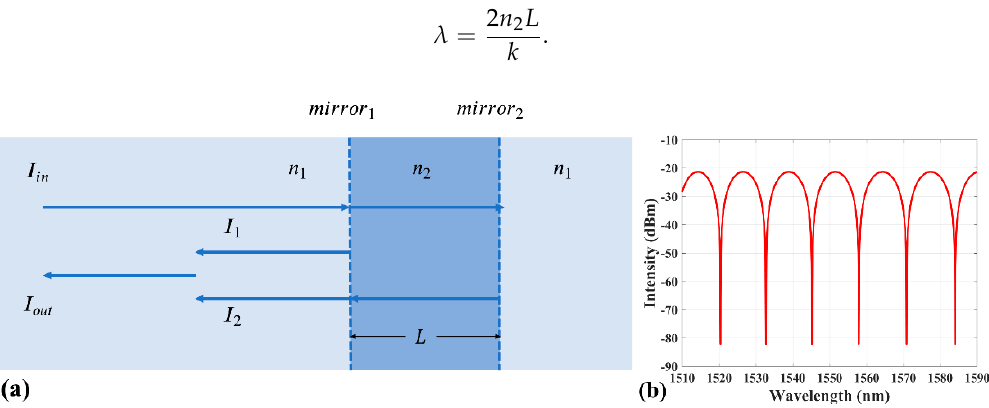
Figure 1. ( a ) The schematic diagram of Fabry–Perot interferometer (EFPI) sensor. ( b ) The theoretical reflection spectrum of EFPI refractive index (RI) sensor.